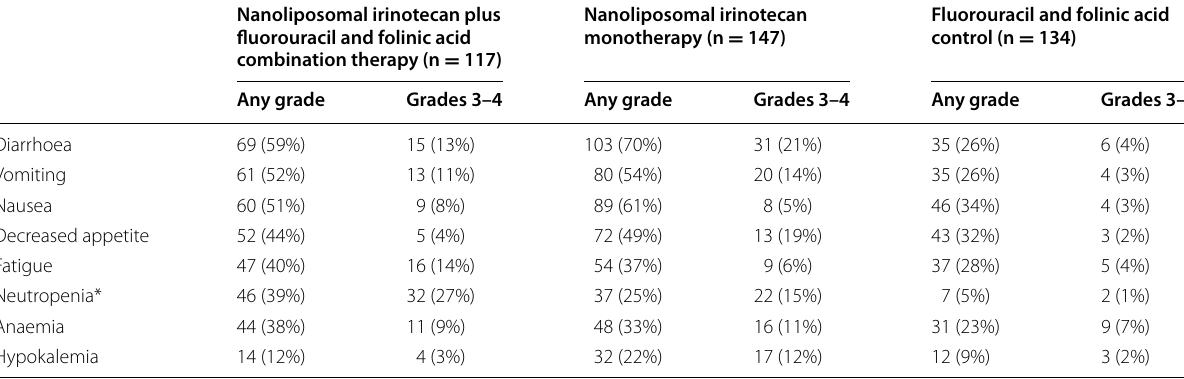
Data are number of patients (%). The table shows grade 3 and 4 adverse events reported in with 2% incidence versus fluorouracil and folinic acid ≥ * Includes agranulocytosis, febrile neutropenia, granulocytopenia, neutropenia, neutropenic sepsis, decreased neutrophil count, and